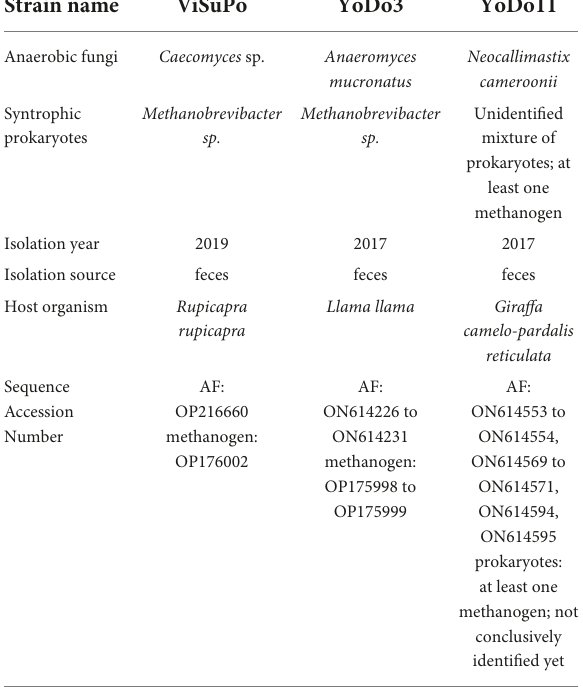
TABLE 1 Strains used in this